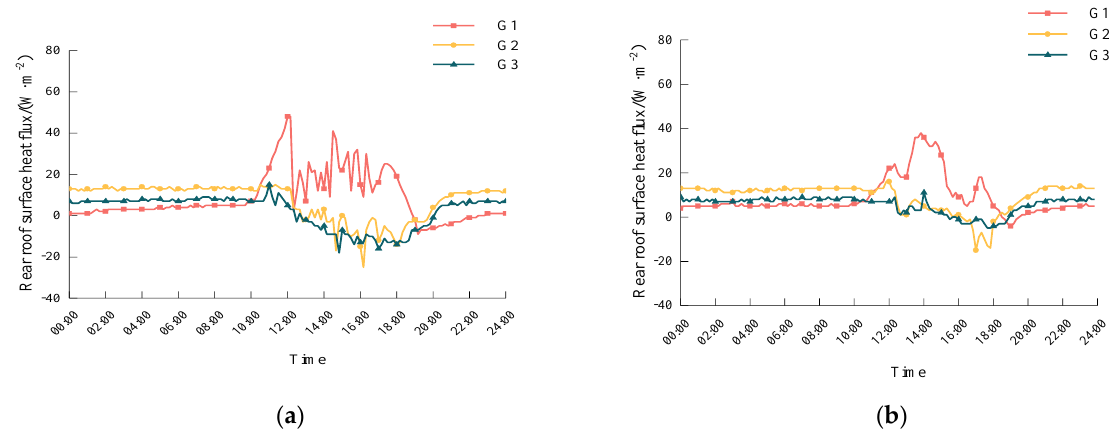
Figure 11. Heat flow change in the north roof of CSGs under typical weather. ( a ) Sunny day (20 February 2022). ( b ) Cloudy day (18 February 2022). (20 February 2022). ( b ) Cloudy day (18 February